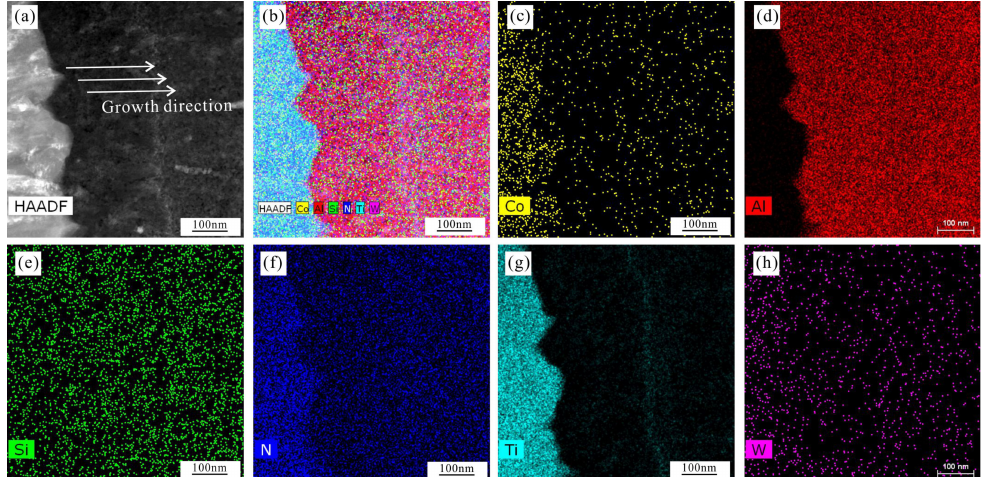
Figure 3. ( a ) HAADF–STEM image of CVD Ti 0.13 Al 0.85 Si 0.02 N coating and EDS mapping images for distribution of ( b ) Co, Al, Si, N, Ti and W; ( c ) Co; ( d ) Al; ( e ) Si; ( f ) N; ( g ) Ti; ( h ) W in CVD Ti 0.13 Al 0.85 Si 0.02 N coating.